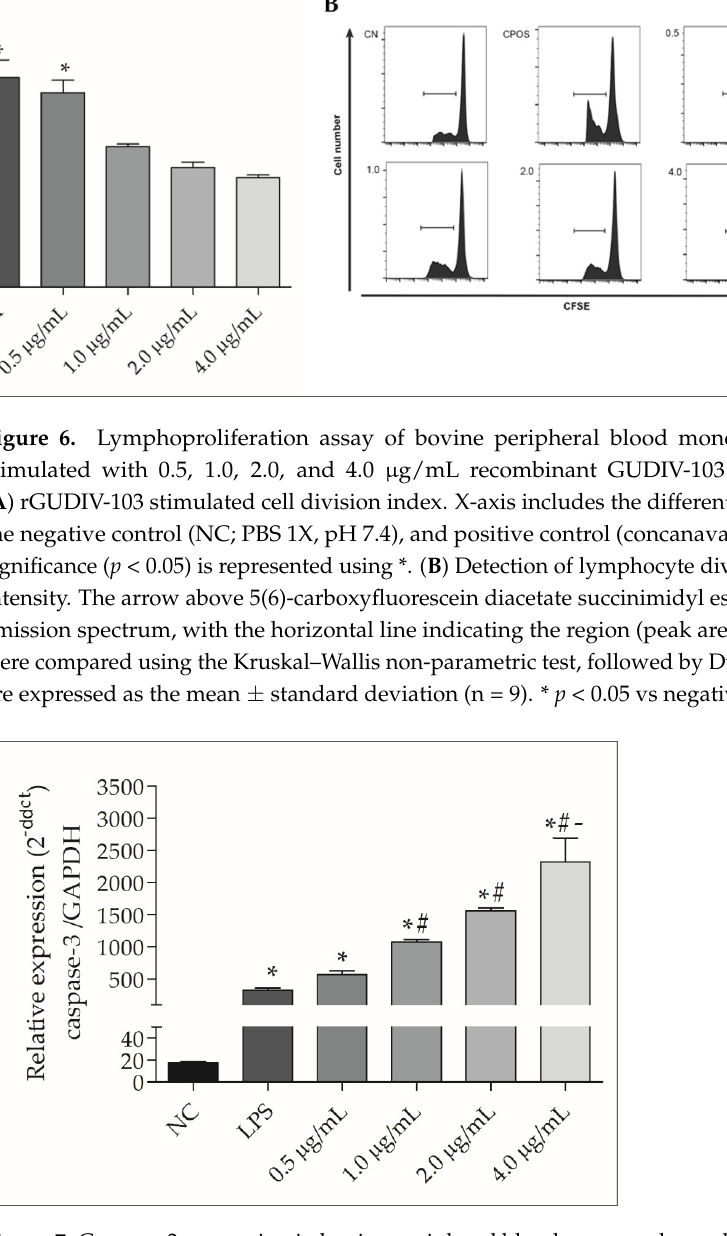
Figure 7. Caspase-3 expression in bovine peripheral blood mononuclear cells (PBMCs) treated with 0.5, 1.0, 2.0, and 4.0 µ g/mL recombinant GUDIV-103 (rGUDIV-103) for 6 h. The negative control (NC) and positive control were PBS at pH 7.4 and LPS (100 ng/mL), respectively. Treatments were compared using the Kruskal–Wallis non-parametric test followed by Dunn’s post hoc test. Different symbols indicate statistically different groups. Statistical significance ( p < 0.05) is represented by the symbols ( ∗ , #, -). Data are expressed as the mean ± standard deviation (n = 9). * p < 0.05 vs negative group. # p < 0.05 vs. LPS group. - p < 0.05 vs 0.5 µ g/mL